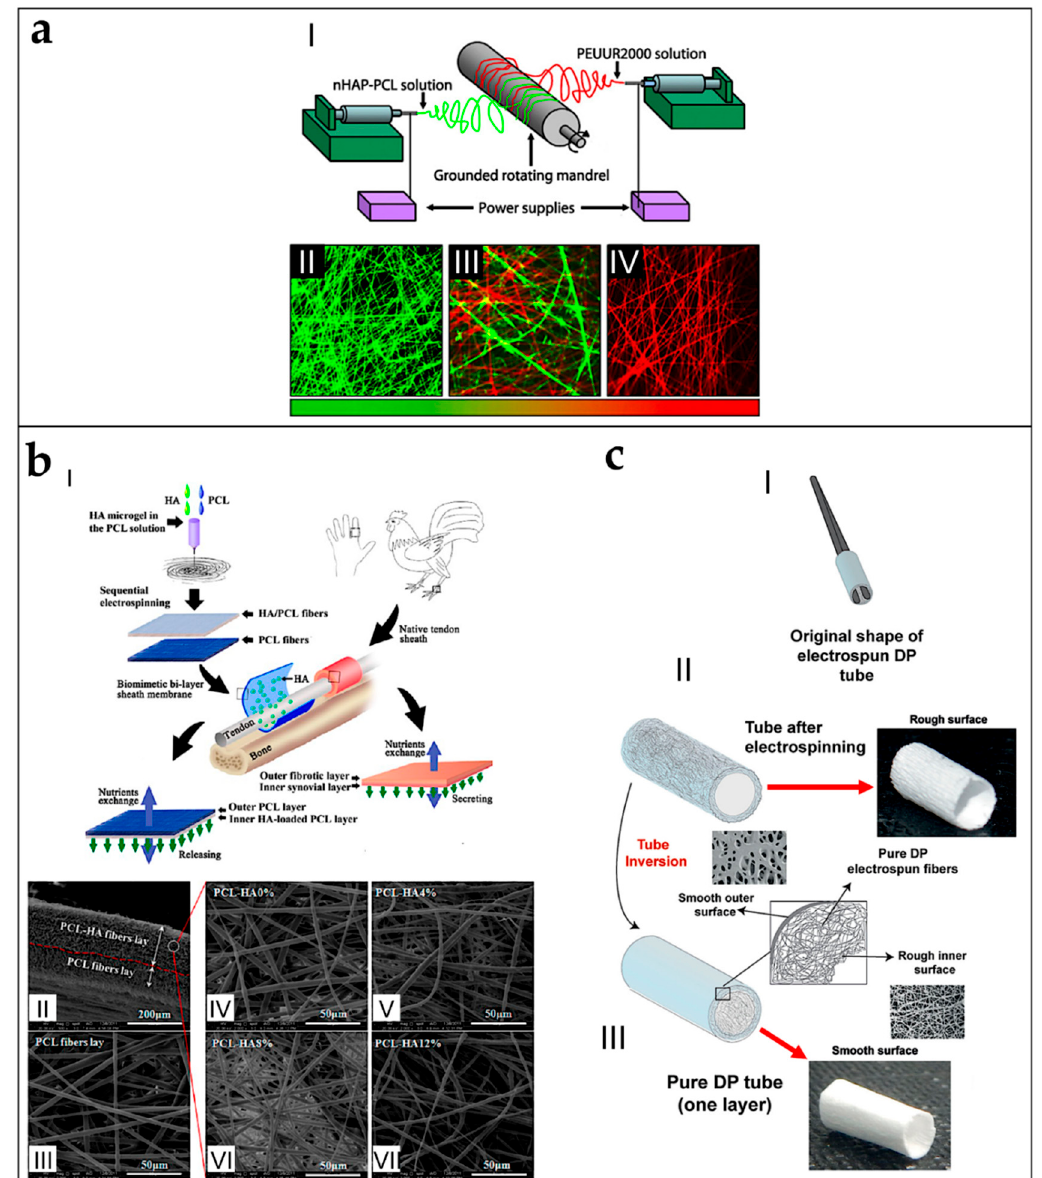
Figure 14. Schematic workflows to produce electrospun scaffolds suitable for tendon/ligament-to-bone attachment or for tendon and ligament healing and anti-adhesion applications. ( a ) Co-electrospun random mats with gradient of PEUUR2000 and PCL, loaded with nanohydroxyapatite (HAp) for ligament-to-bone regeneration (adapted from Samavedi et al. [110], reproduced with permission. Copyright 2011, Elsevier): (I) co-electrospinning setup to obtain nanofibrous mats with